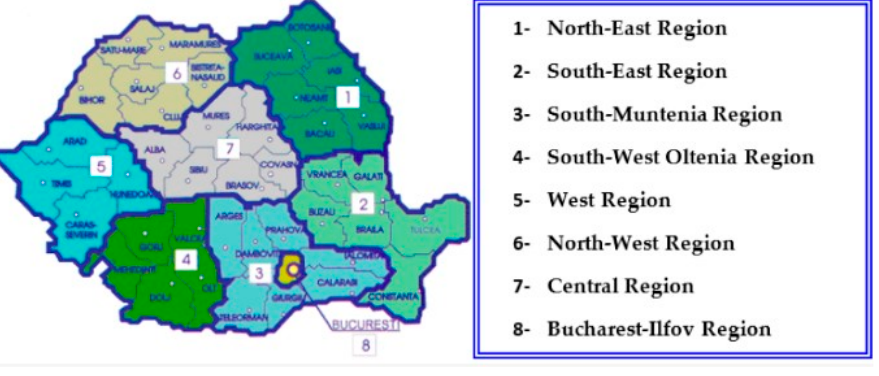
Figure 5. Romania’s development regions [37].